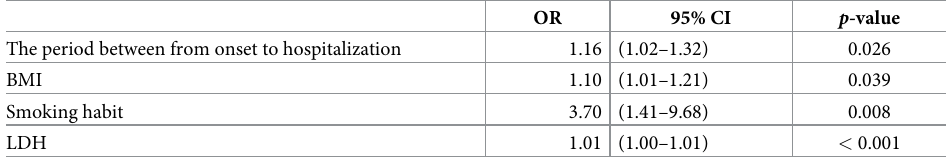
Table 5. Multivariable logistic regression (n =